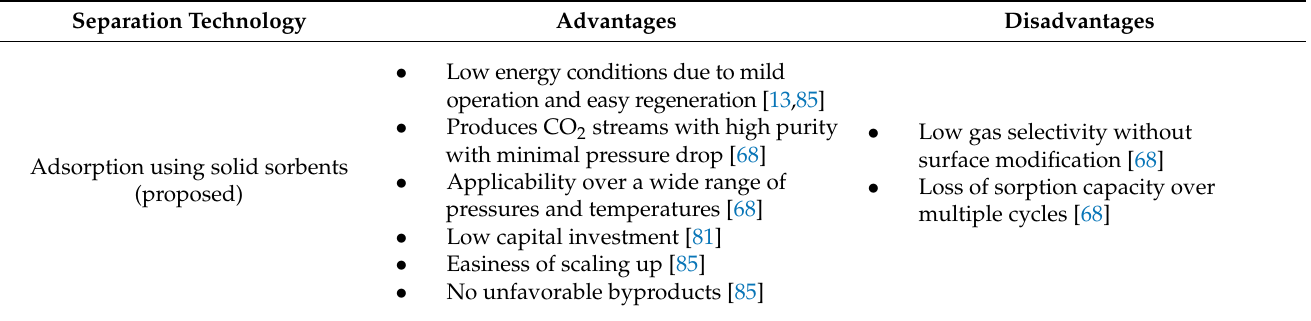
Table 3. Advantages and disadvantages of adsorption process and amine-based absorption processes. Separation Technology